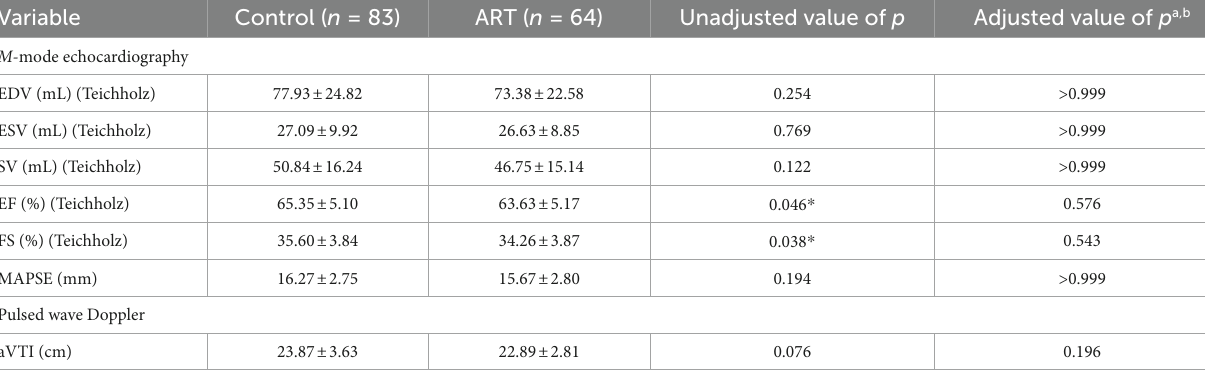
TABLE 3 Left ventricular systolic function assessed by M -mode echocardiography and pulsed wave Doppler. Variable